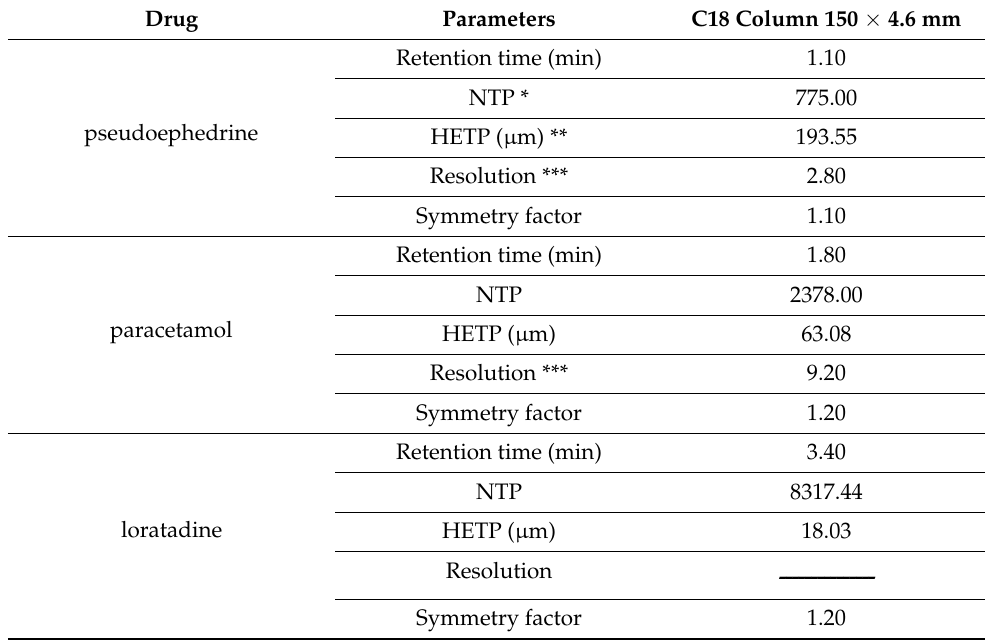
Table 2. System suitability parameters of the developed HPLC-PDA method.